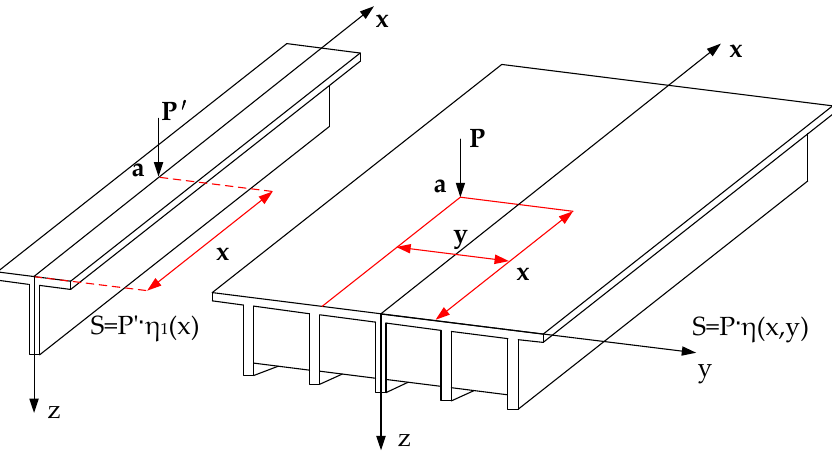
Figure 3. The internal force calculation under vehicle load.